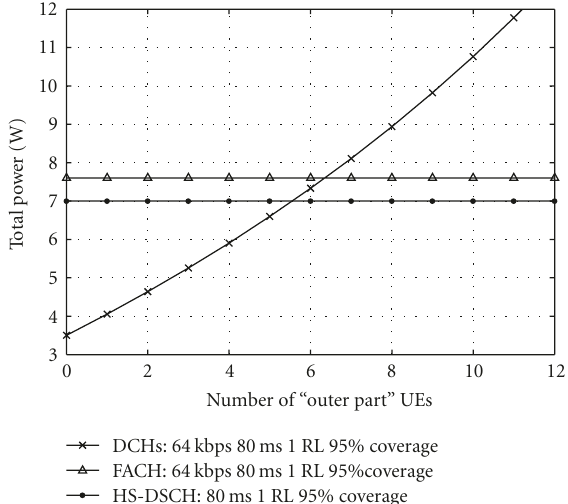
Figure 8: Node B’s Tx power with Mixed Usage of Multiple DCH channels and